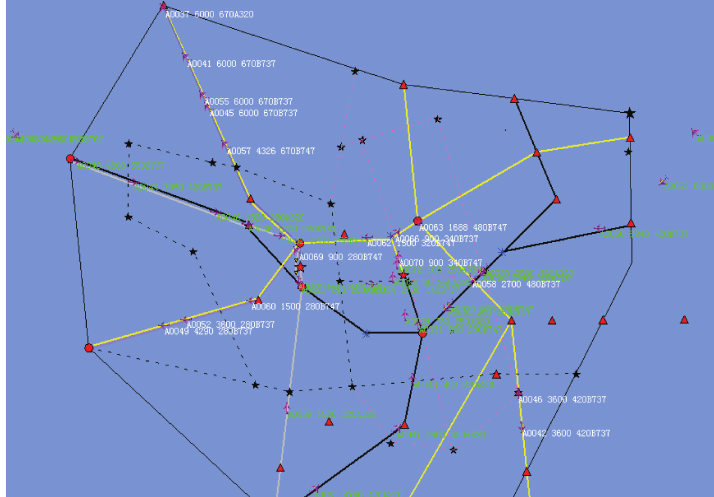
Figure 19: 4D trajectory simulating for Shanghai terminal control